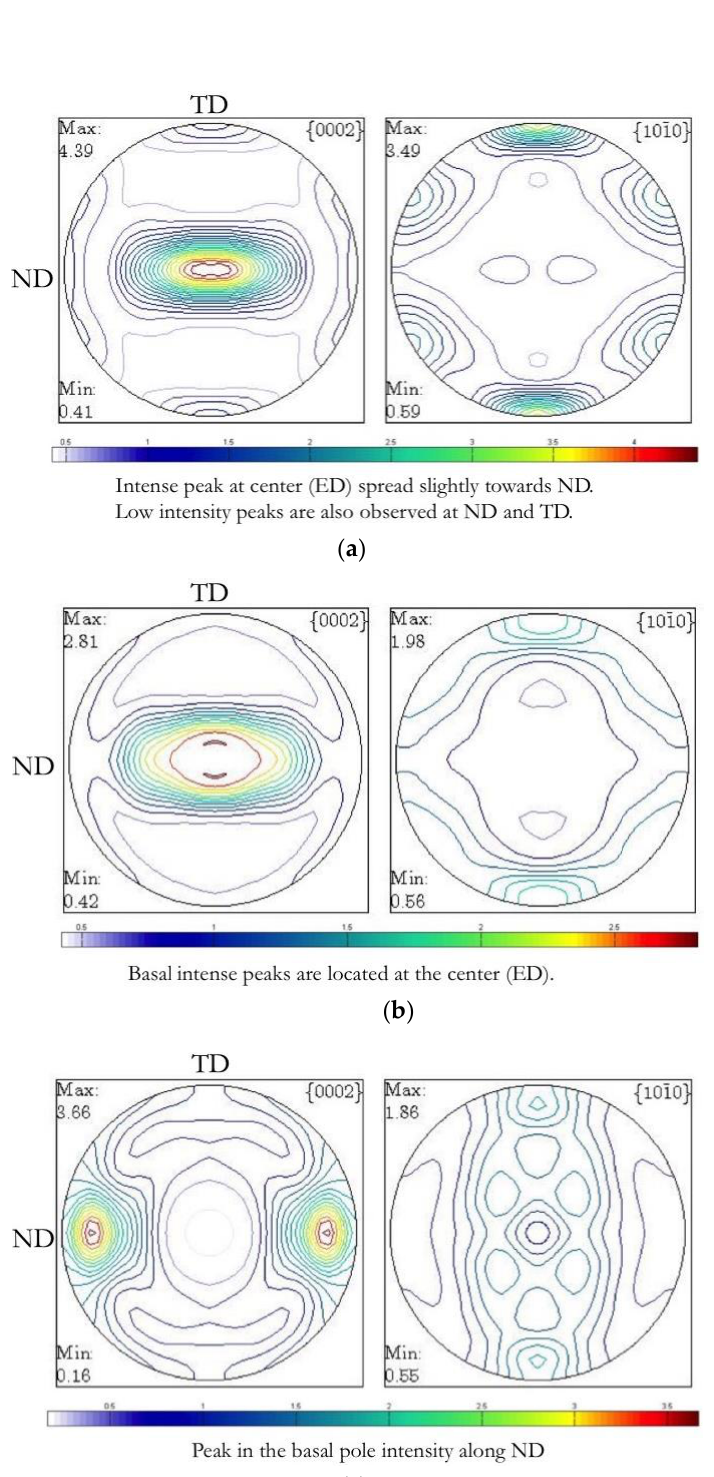
Figure 11. XRD pole figures of the specimens deformed under ND loading at the peak efficiency conditions corresponding to the Domains 2, 3, and 4 of the ND processing map. ND (the compression axis) is along the horizontal axis, and the vertical axis is TD. ( a ) 400 °C and 0.0003 s −1 (Domain 2); ( b ) 500 °C and 0.0003 s −1 (Domain 3); ( c ) 300 °C and 10 s −1 (Domain 4).